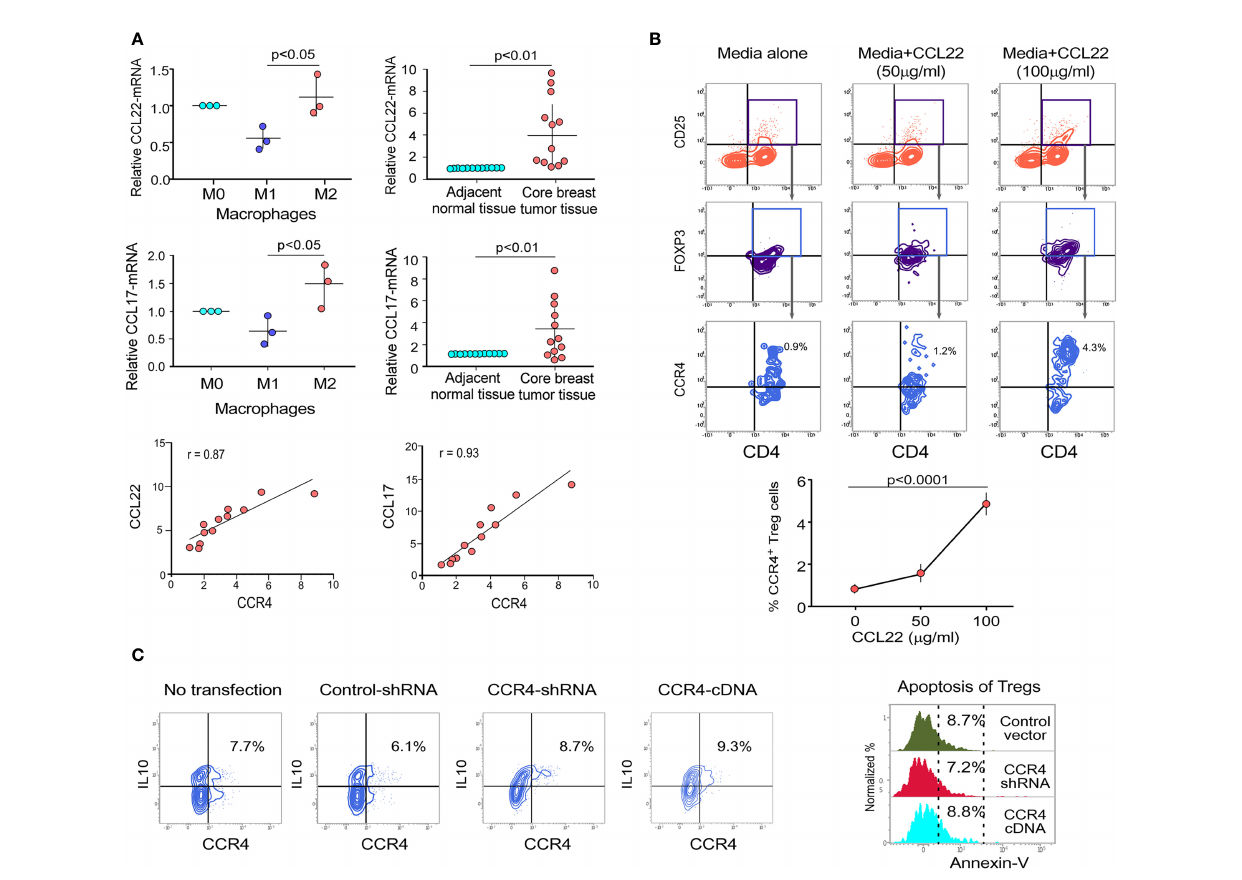
FIGURE 2 | Cell surface receptor CCR4 interacts with chemokine CCL22 and CCL17 to migrate Treg cells into tumor microenvironment. (A) Relative mRNA expression of CCL22 (upper left panel) and CCL17 (middle left panel) in various macrophage subpopulations (M0, M1, and M2). CCL22 (upper right panel) and CCL17 (middle right panel) relative mRNA expression in neighboring non-tumor/normal tissue and core breast tumor tissue acquired from breast cancer patients at various stages ( n = 12). The correlation between CCR4-CCL22 (lower left panel) and CCR4-CCL17 (lower right panel) in core breast tumor tissue taken from various stages of breast cancer patients ( n = 12) is depicted in representative correlation coef fi cient plots. (B) Flow cytometry was used to examine the migration of CD4 + CD25 + FOXP3 + CCR4 + Tregs in response to recombinant CCL22 in a trans-well plate (representative plot) (upper panel). Graphical representation of the percentage of CCR4 + Treg populations after trans-well migration (lower panel). (C) Control-shRNA, CCR4-shRNA, and CCR4-cDNA clones were transfected into ex vivo -generated Treg cells, and intracellular IL10 was measured by fl ow cytometry (left panel). CCR4 expression was genetically altered in ex vivo -generated Tregs, and percentage cell death was assessed fl ow cytometrically by Annexin V positivity after 48 h and depicted in a histo-plot (right panel). As an internal control, GAPDH was used. The values are the mean ± SD of three sets of independent